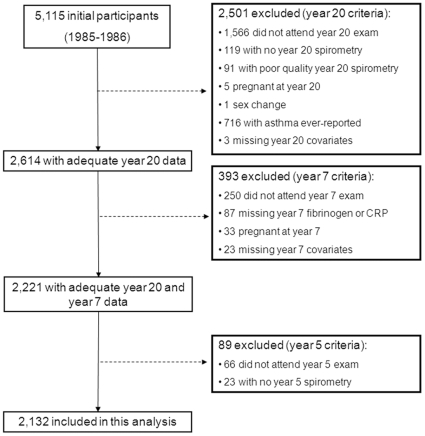
Summary of the population from CARDIA included in the present analysis.